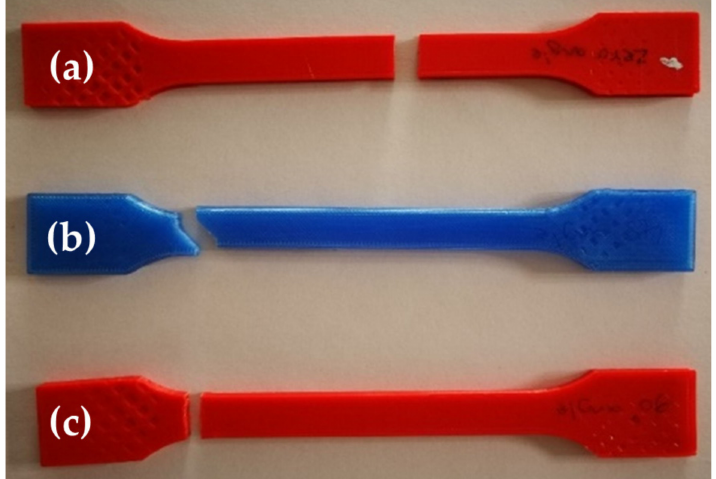
Figure 10. Specimens fractured due to tensile load. Specimens from top to bottom, ( a ) 0 ◦ , ( b ) 45 ◦ , and ( c ) 90 ◦